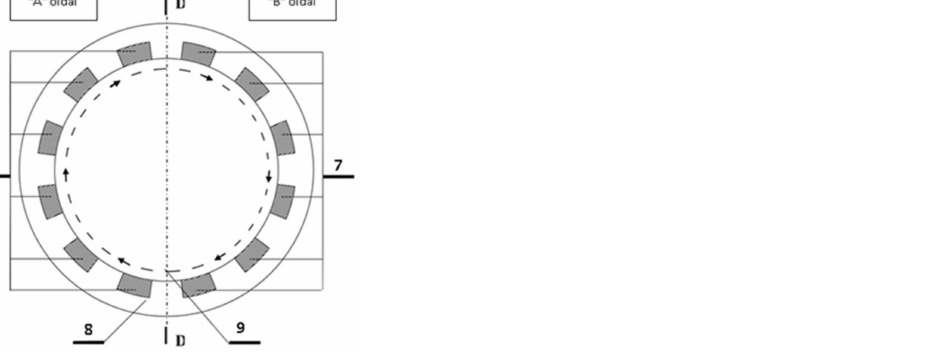
Figure 4. Front view of the four-pole RMF inductor developing the rotating magnetic field “6”, “7”: exciting coils, “8”: closed iron core, “9”: moving direction of rotating magnetic field.